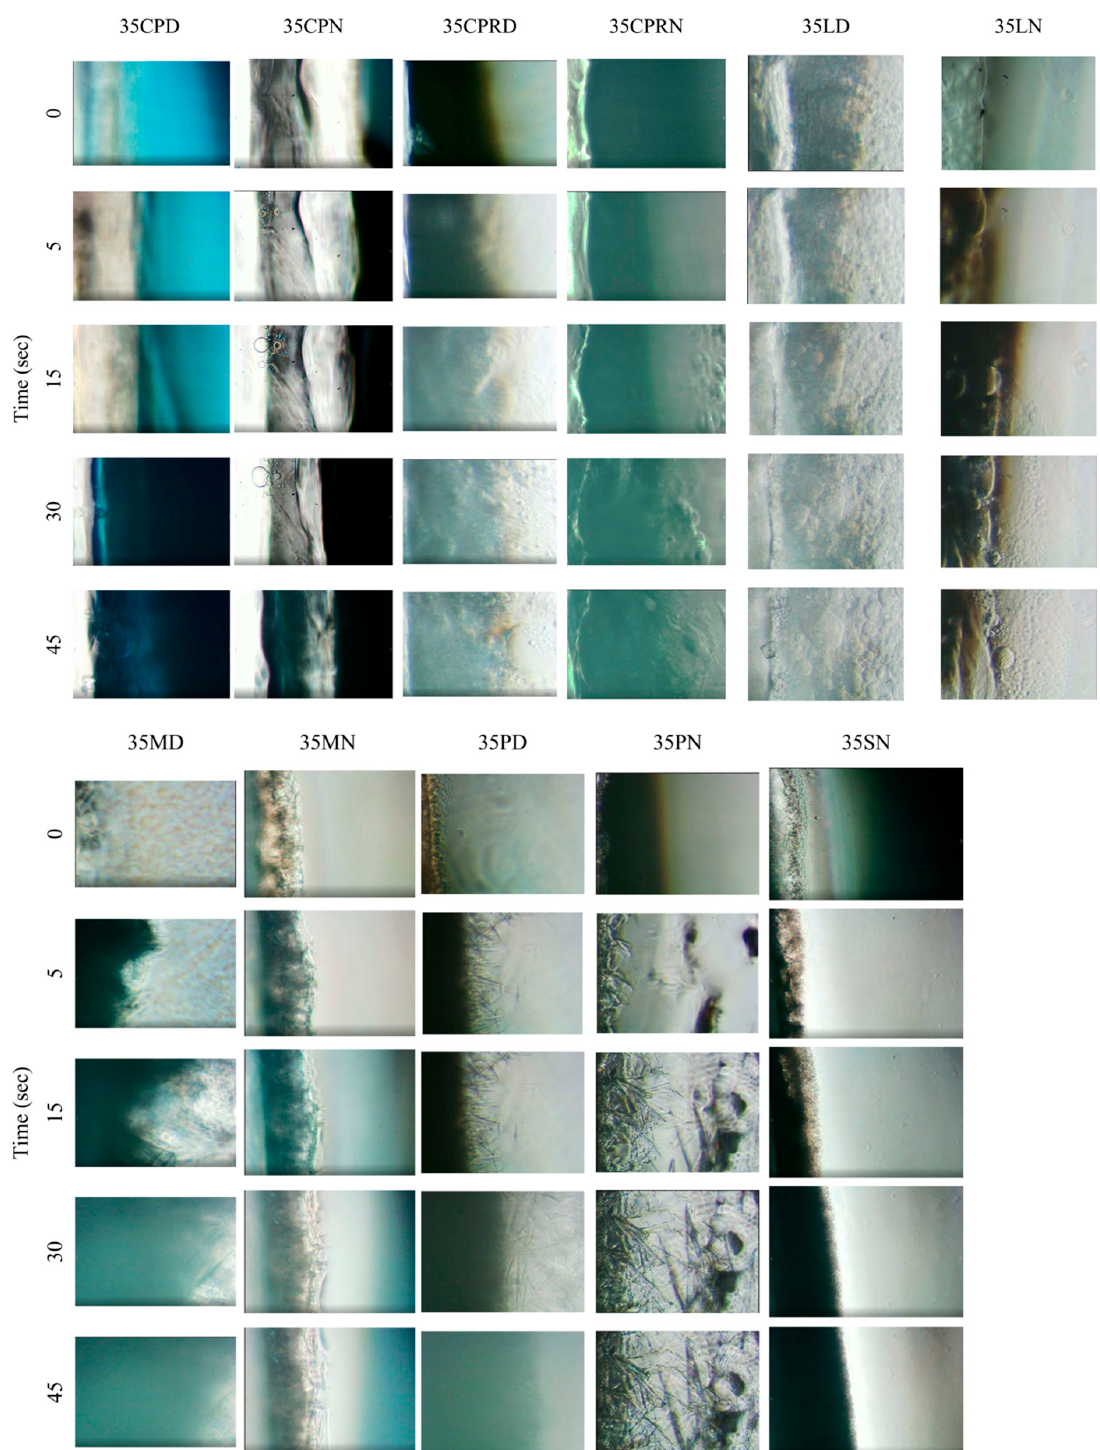
Figure 3. Behaviors of preparations at the boundary of aqueous phase and in situ forming systems during the initial period (0–45 s) at 100x magnification under inverted microscope.